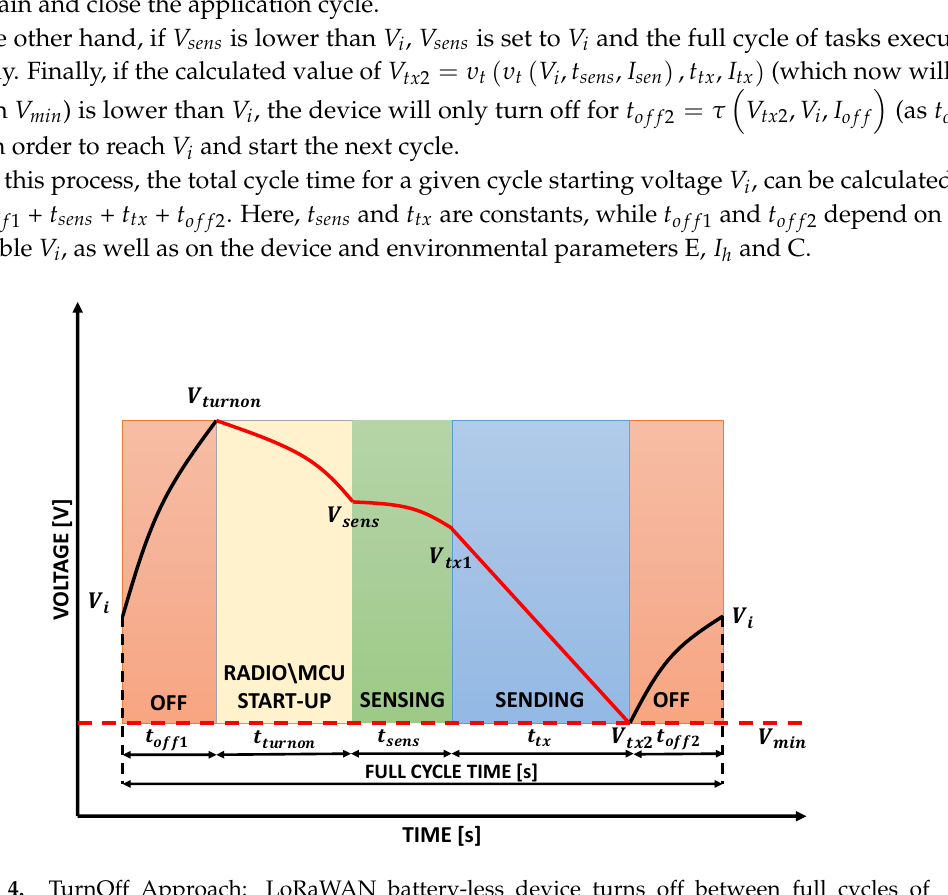
Figure 4. TurnOff Approach: LoRaWAN battery-less device turns off between full cycles of application